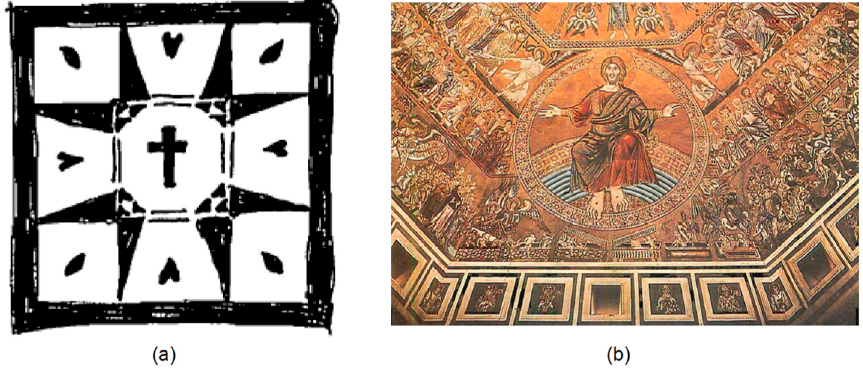
Figure 10. (Color online) Living structure enabling us to see the luminous ground. Note: ( a ) A small humble panel made of marble strips inlaid in the west wall, and ( b ) gold and mosaic ceiling, of the Baptistery, Florence, 11th century [1].